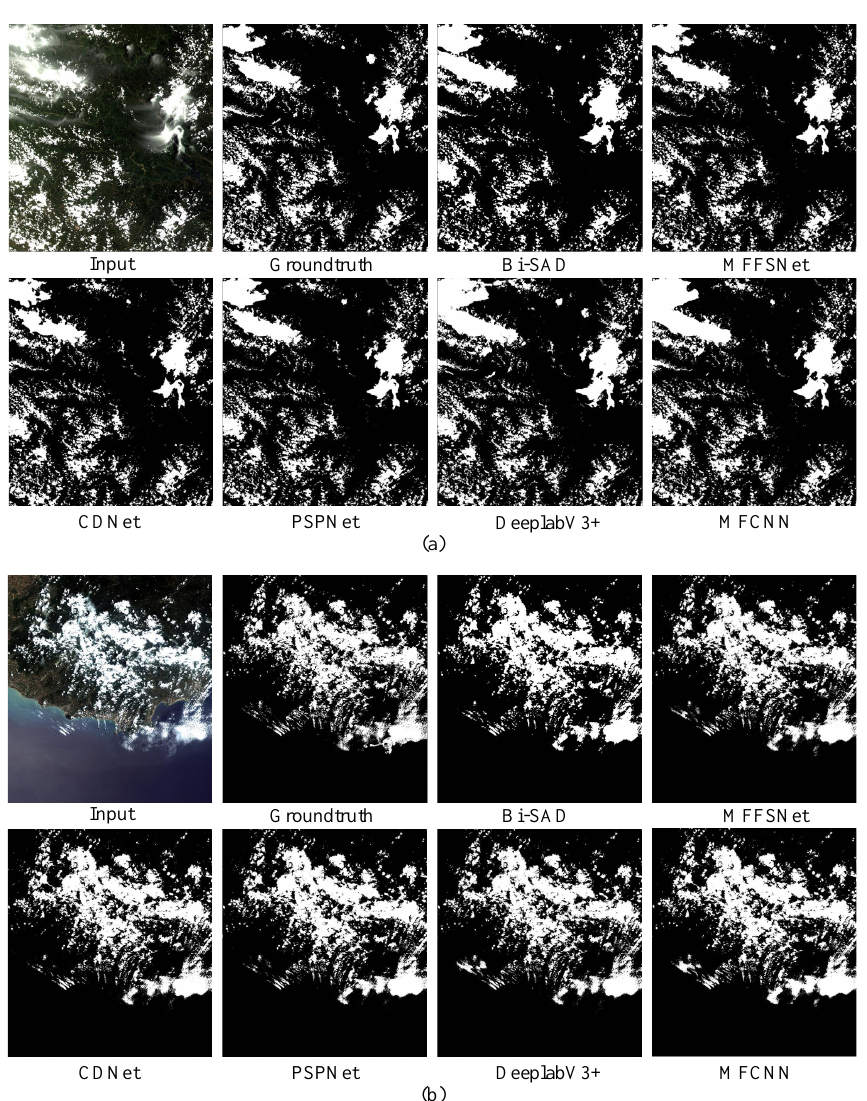
Figure 11. Visual comparisons of cloud detection results of GaoFen-1 image with our method, MFFSNet [24], CDNet [27], PSPNet [23], DeeplabV3+ [22], and MFCNN [25]. ( a ) Spliced visual cloud detection results of GF-1 image(GF1_WFV2_E105.8_ N24.3_ 20140723_L2A0000305784). ( b ) Spliced